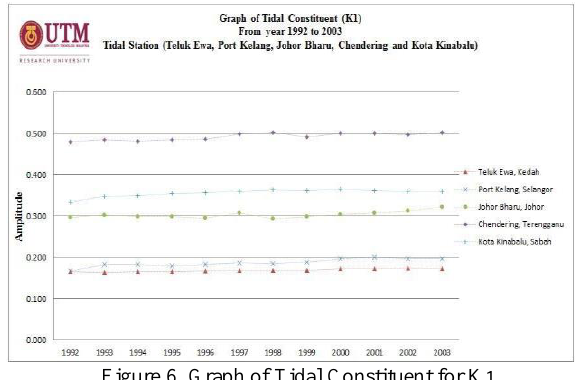
Figure 8. Graph of Tidal Constituent for Sa